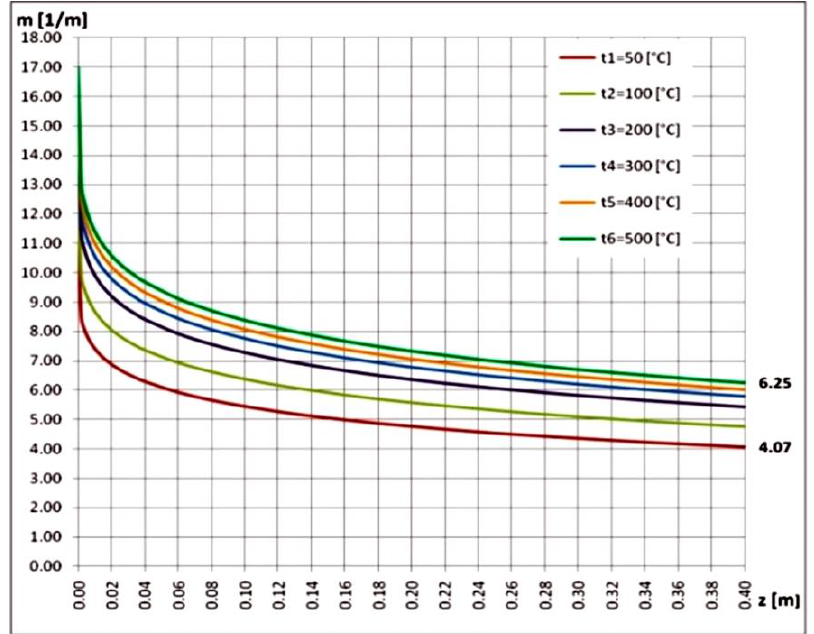
Figure 17. The variation in the parameter “ m ” for the whole length of the bar (cid:96) = z = 0.40 m , corresponding to α g = 0 ◦ angular positioning.